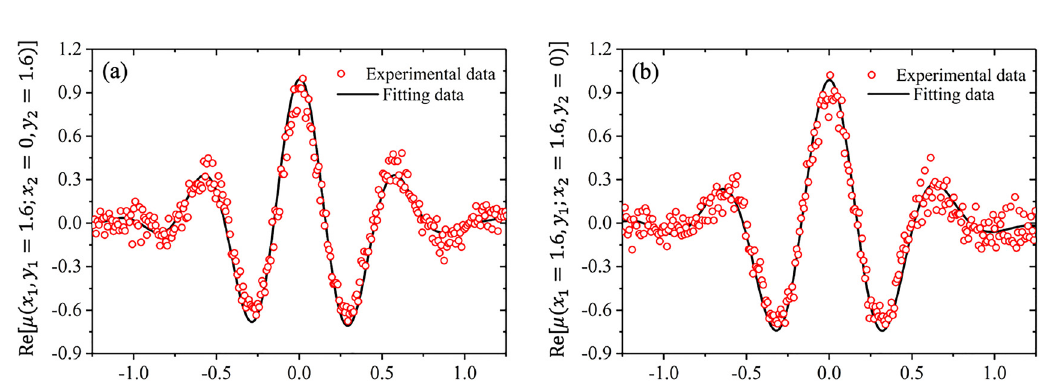
Figure 4: (a) – (d) Experimental and (e) – (h) simulation results of the real part of the DOC of the TGSM beam in the source plane with different reference points r 2 .